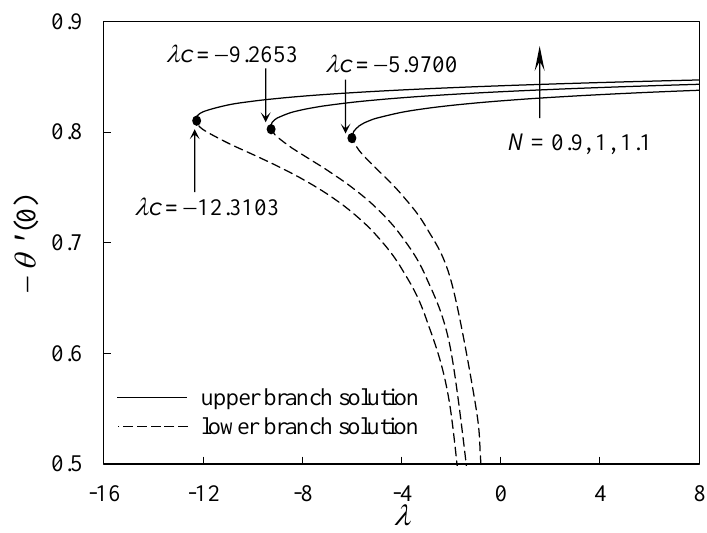
  0    0  with  for several values of N for Cu-water nanofluid. Figure 6. Variation of − θ (cid:48) ( 0 ) with λ for several values of N for Cu-water nanofluid. Figure 6. Variation of Figure 6. Variation of with  for several values of N for Cu-water nanofluid.